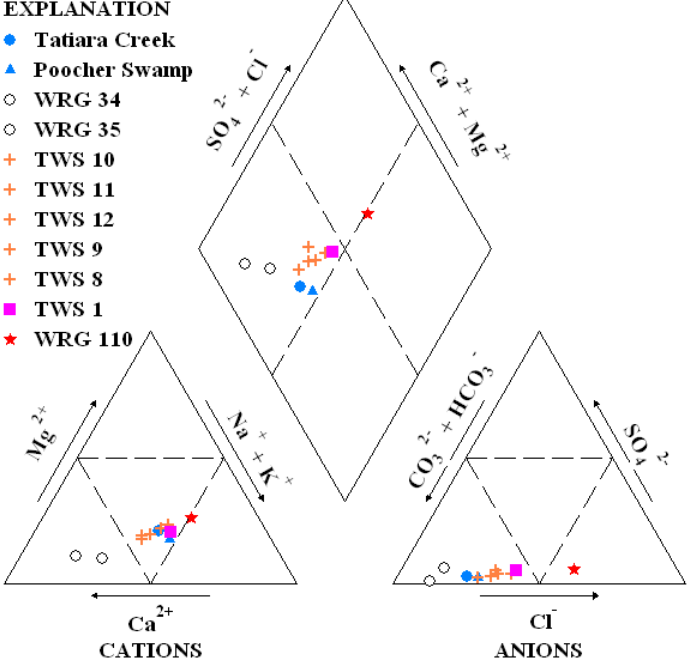
Figure 13. Piper diagram for fresh water